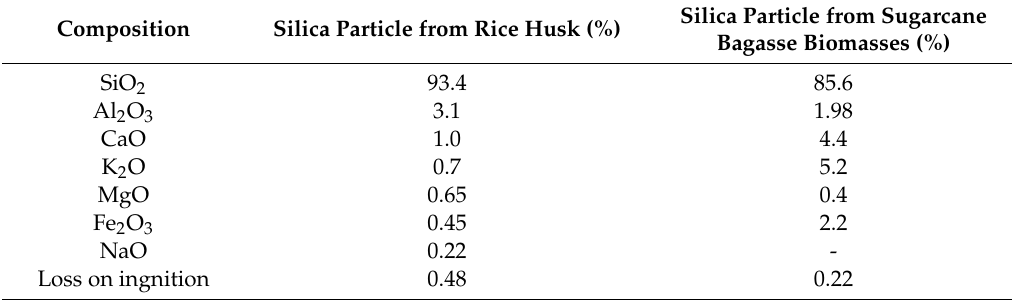
Table 1. Composition of silica particles.